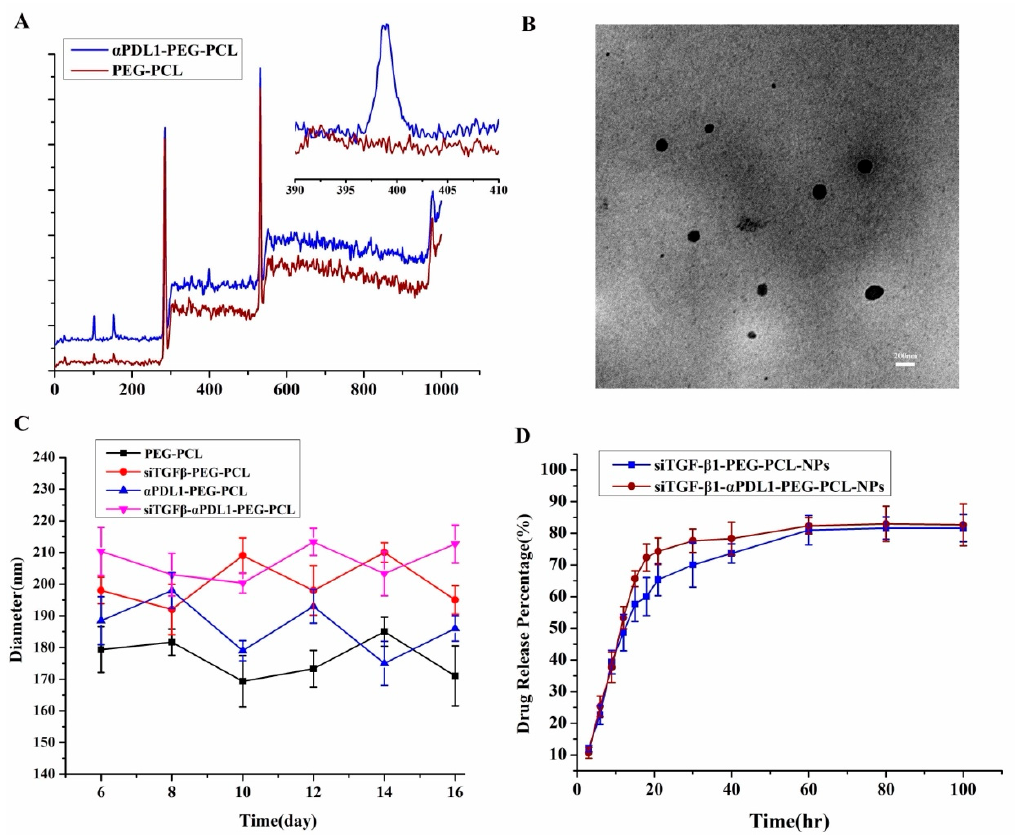
Figure 1. Characterization of siTGF- β 1- α PDL1-PEG-PCL-NPs. ( A ) Representative XPS spectra and N 1s peaks (insets) of α PDL1-PEG-PCL NPs before (lower panel) and after (upper panel) α PDL1 conjugation. ( B ) Morphology of siTGF- β 1- α PDL1-PEG-PCL-NPs by TEM. Scale bar, 200 nm. ( C ) Stability study of the produced NPs. The diameters of the NPs were determined by DLS, and data are mean ± SD. ( D ) In vitro release of siTGF- β 1 from α PDL1-PEG-PCL-NPs and PEG-PCL-NPs. Data are mean ± SD (XPS, X-ray photoelectron spectroscopy, siTGF- β 1, Transforming Growth Fac- tor- β 1 siRNA, α PDL1, anti-programmed cell death-Ligand 1; TEM, transmission electron micro- scope; NPs, nanoparticles; DLS, Dynamic light scattering).